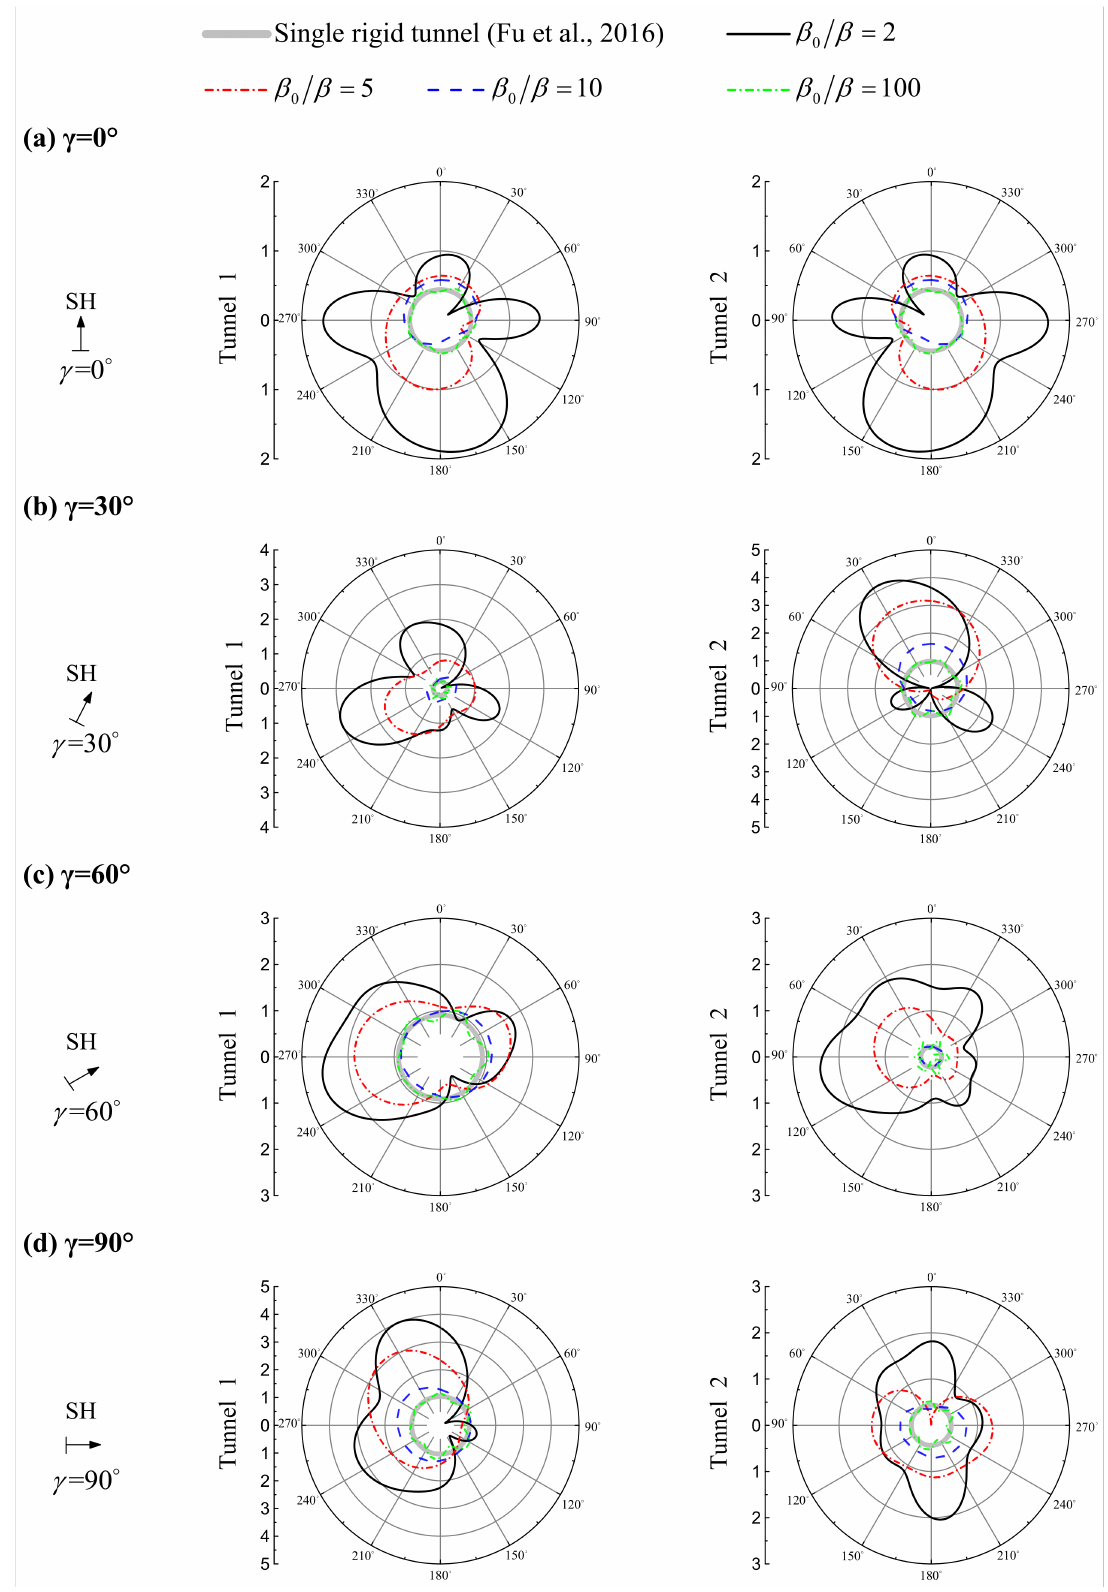
Figure 5. Typical spectral amplification of the tunnel displacement responses under different incident angles ( γ ). Tunnel burial depth D / a = 2, tunnel distance s / a = 5, dimensionless frequency η = 1.0. Left column: tunnel 1; right column: tunnel 2. Parts ( a – d ) correspond to the incident angle γ = 0 ◦ (vertical incident), 30 ◦ , 60 ◦ , and 90 ◦ (horizontal incident),